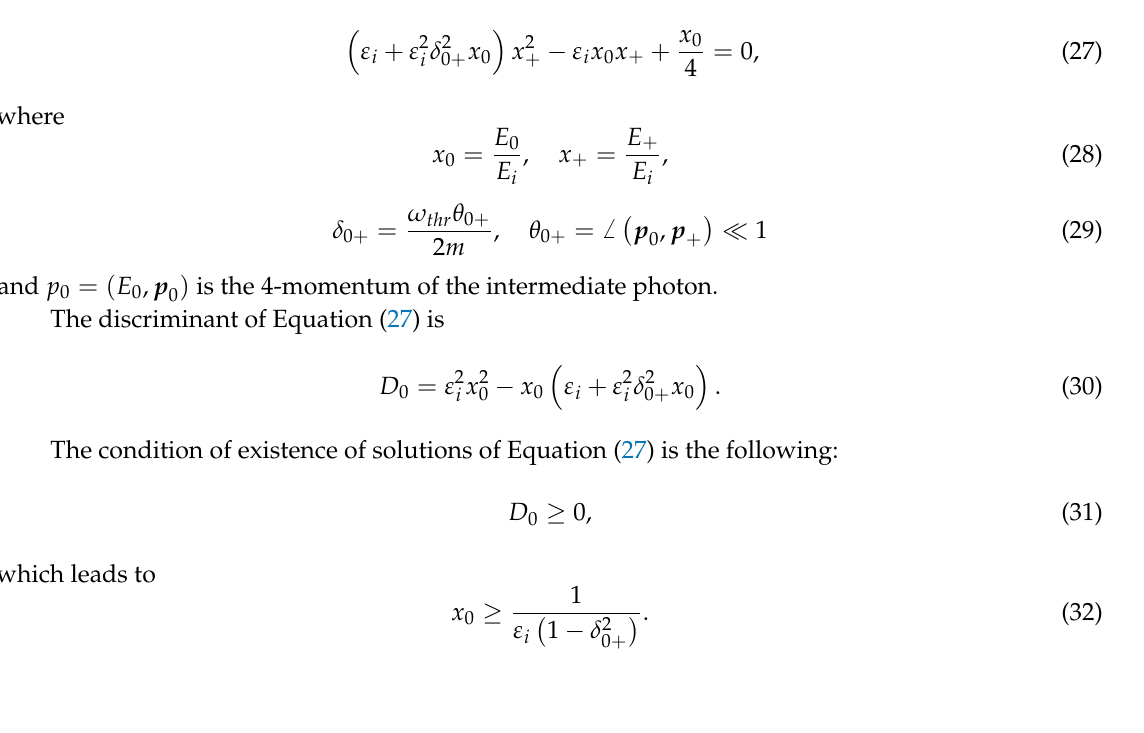
Figure 3. ( a ) The energy of the final electron as a function of parameter δ 2 of the initial electron from the closed interval ε i ∈ [ ε thr , ε ∗ ] . ( b ) The energy of final electron as a function of parameter δ 2 for different values of energy of the initial electron satisfying the condition ε i > ε ∗ fi